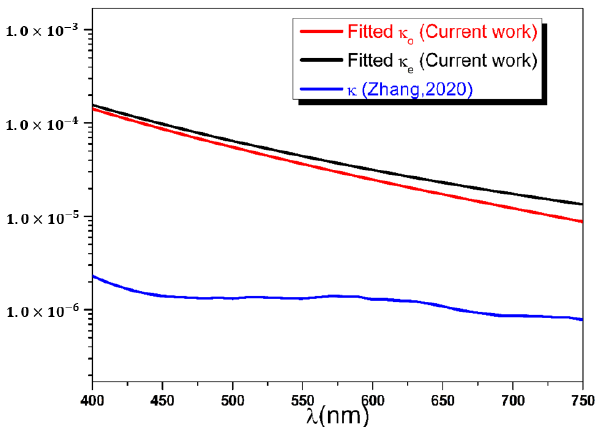
Figure 14. Extinction coefficients’ dispersion curves represented in logarithmic scale and compared with results of reference [11].